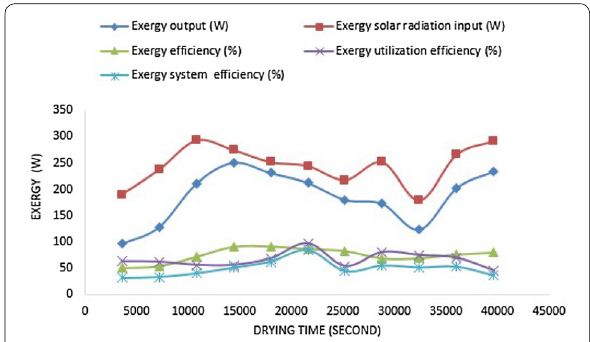
Fig. 21 Variation of efficiency as a function of drying time and exergy